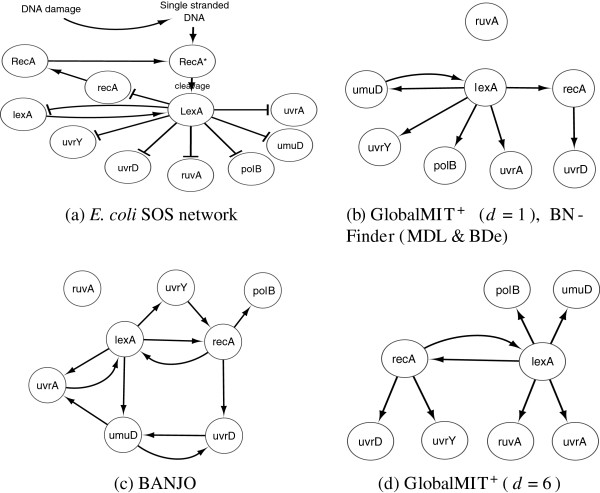
Experimental results on theE. coliSOS network.